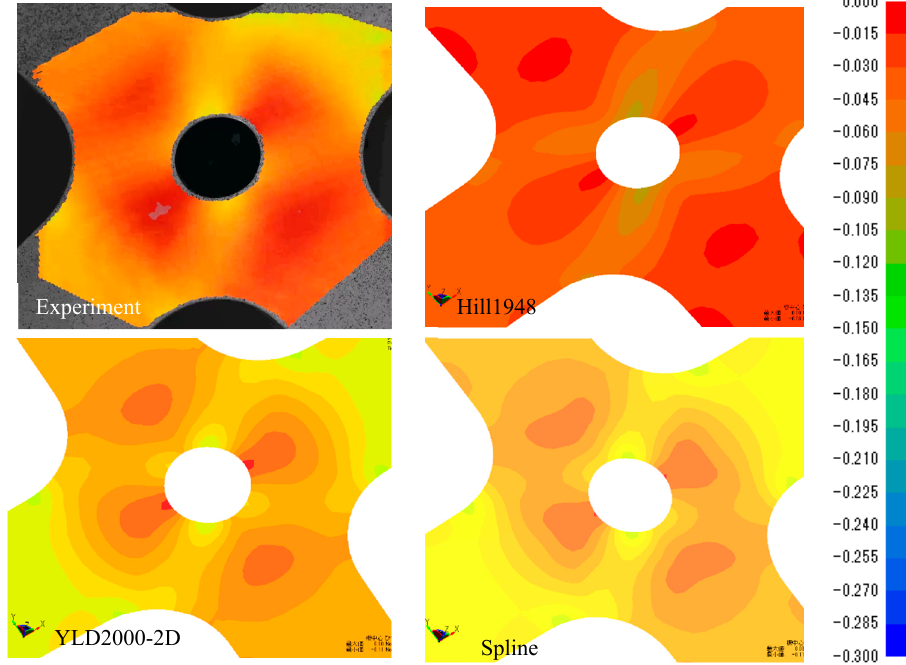
Figure 17. Comparison of thickness strain distribution contours of experimental condition F.